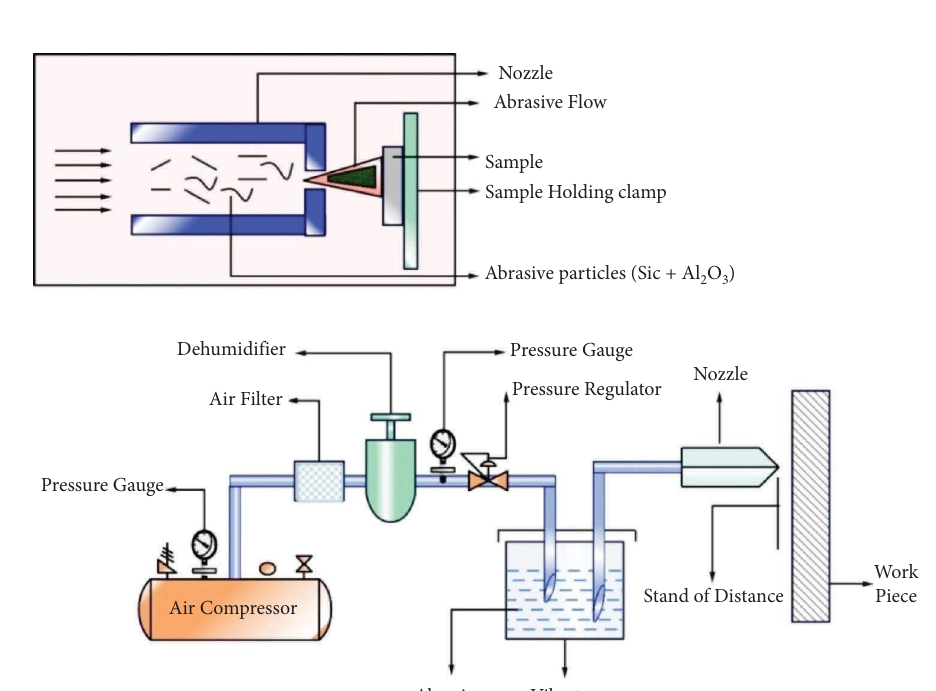
Figure 1: Flow diagram of the abrasive jet machine.